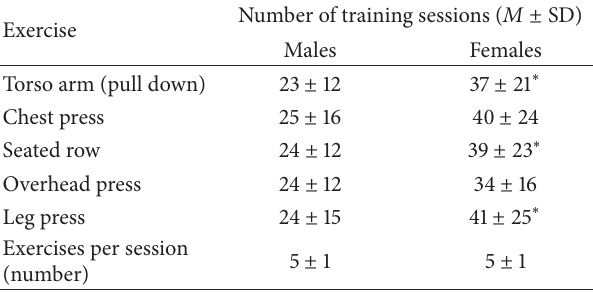
Table 2: Participant training session